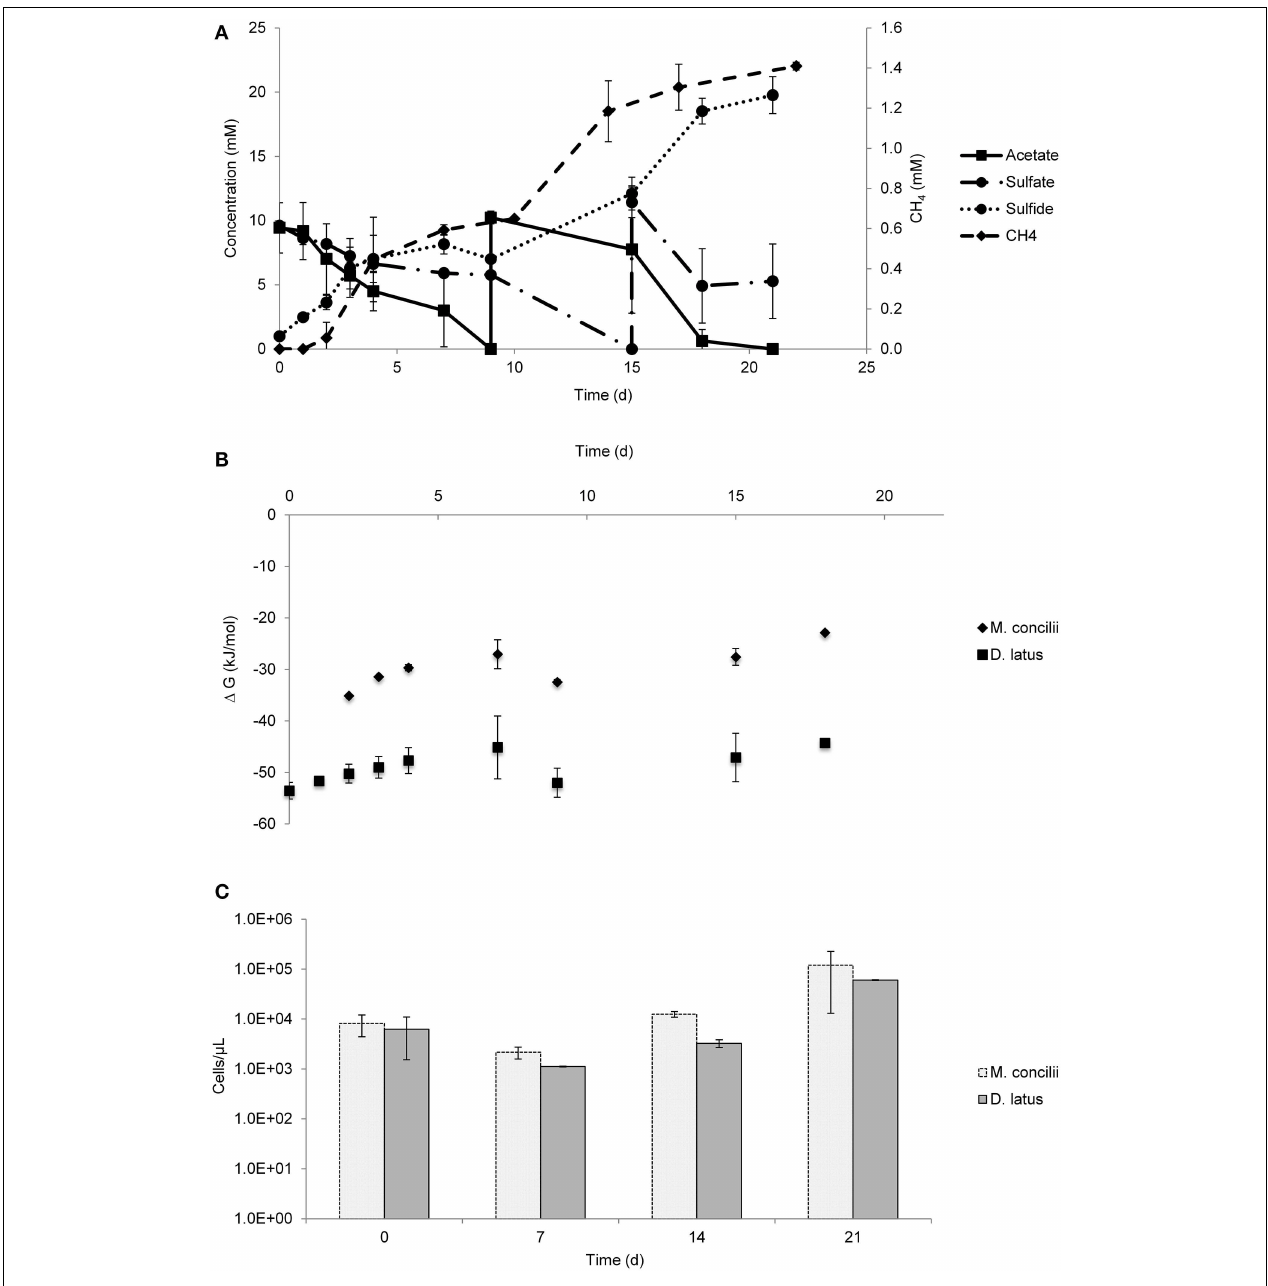
FIGURE 3 | Growth on acetate by coculture of M. concilii and D. latus . (A) Changes in acetate, sulfate, sulfide, and methane. (B) Actual Gibbs free-energy changes for acetate degradation to sulfide